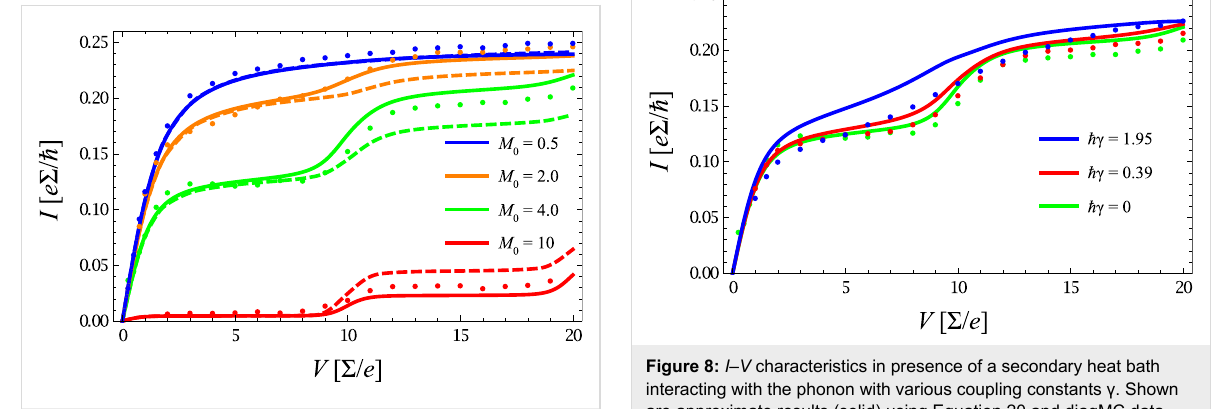
Figure 7: As Figure 6 but for fixed ω 0 / ∑ = 5 and varying electron–phonon coupling.